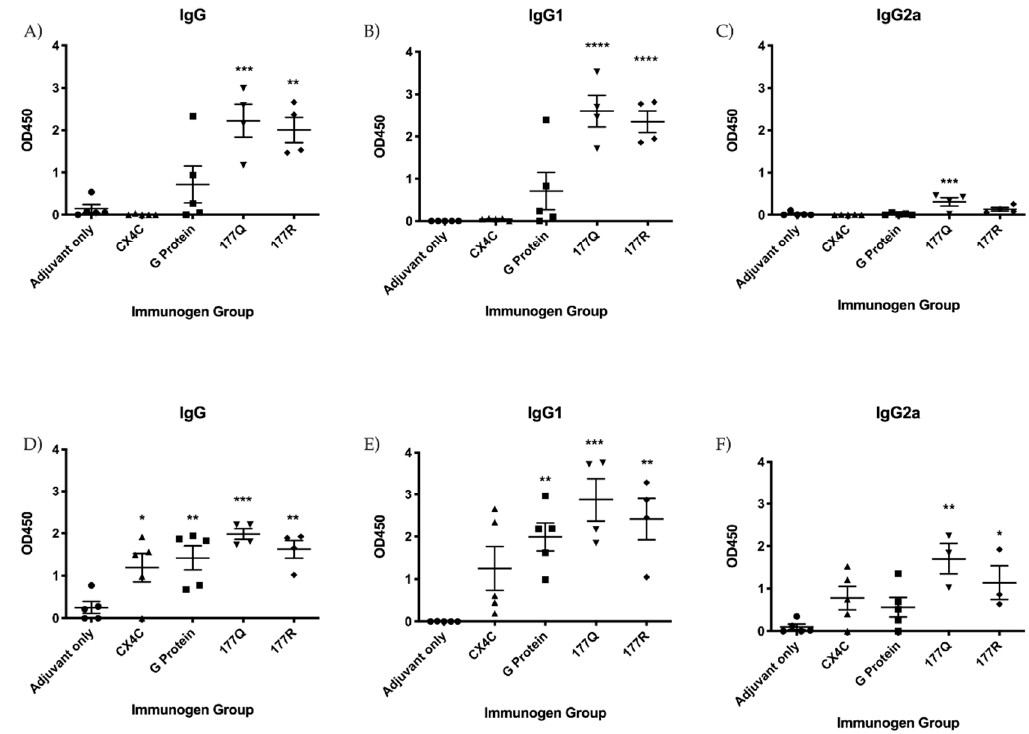
Figure 3. Immunogen vaccination induces anti-RSV IgG. Antibody levels were detected by indirect anti-RSV ELISA specific for total IgG ( A , D ); IgG1 ( B , E ); IgG2a ( C , F ) on days 0 ( A–C ) and day 7 ( D–F ) post-challenge. Graphs are representative of three independent experiments. Data represents the mean value of 3 experiments subtracted from the background. Bars represent the mean OD450 + SEM. n = 3–5 animals per group. Data were analyzed by one-way ANOVA tests where * p < 0.05, ** p < 0.01, *** p < 0.001, **** p < 0.0001 compared to adjuvant-only group.